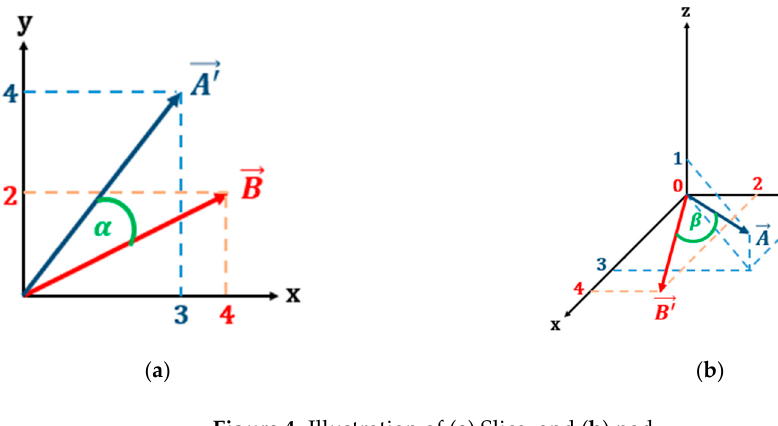
Figure 4. Illustration of ( a ) Slice, and ( b ) pad.